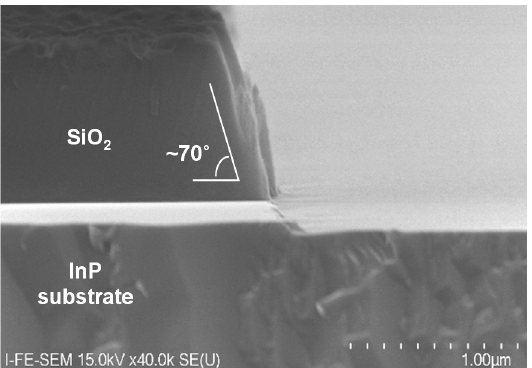
Figure 3. SEM images near a sidewall of a dry-etched SiO 2 layer patterned on InP substrate. An experiment to determine the appropriate value of RF power in the ICP etcher for InP dry etching was performed. The fabrication results of InP via holes etched at different levels of RF power of 275 W, 288 W, 294 W, and 300 W are shown in Figure 4, where Figure 4a,b show SEM images of representative etch profiles and the InP etch rate and sidewall surface roughness of the fabricated InP via holes, respectively. Error bars in Figure 4b represent the deviation values incurred by the process variation for a total of 60 InP via holes with the same layout width in the three fabrication lots. ICP power